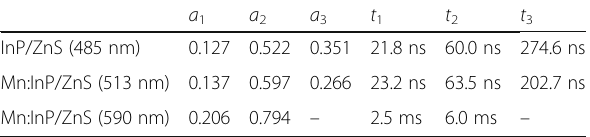
Table 2 Decay times and amplitude constant ratios of PL emission for InP/ZnS (Mn/In = 0) and Mn:InP/ZnS (Mn/In = 0.6) QDs a 1